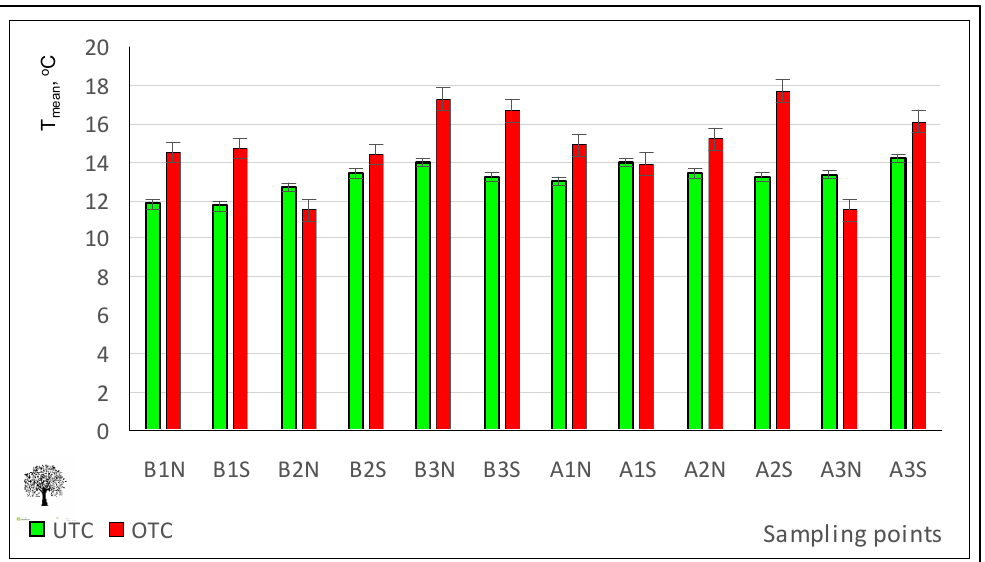
Figure 18. Mean temperature (T mean ) in April 2016, outside tree canopy (OTC) and under tree canopy (UTC).